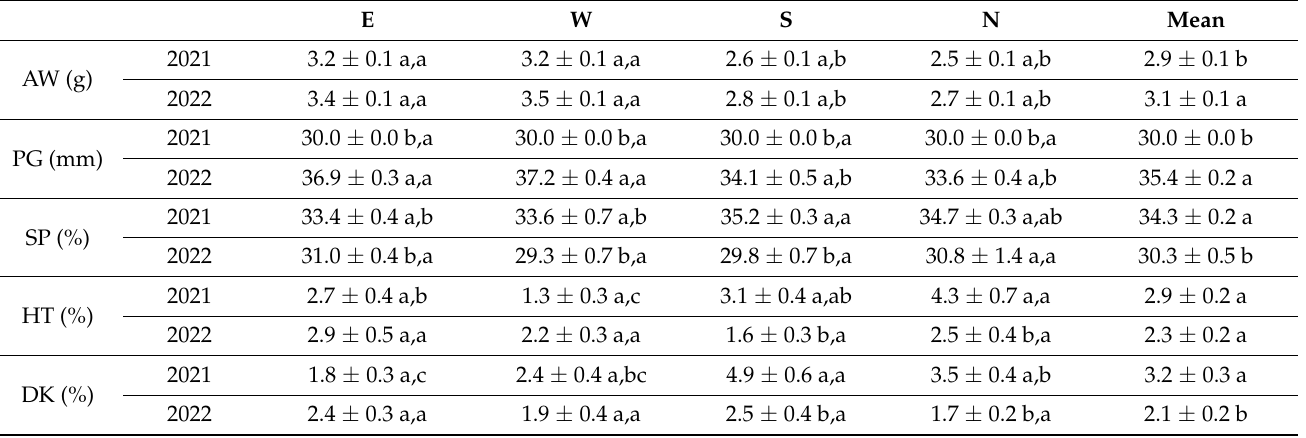
Table 5. Almonds’ quality parameters for 2021 and 2022 in different expositions (E, W, S, N). The first letters denote statistical differences between years for an exposition; second letters denote statistical